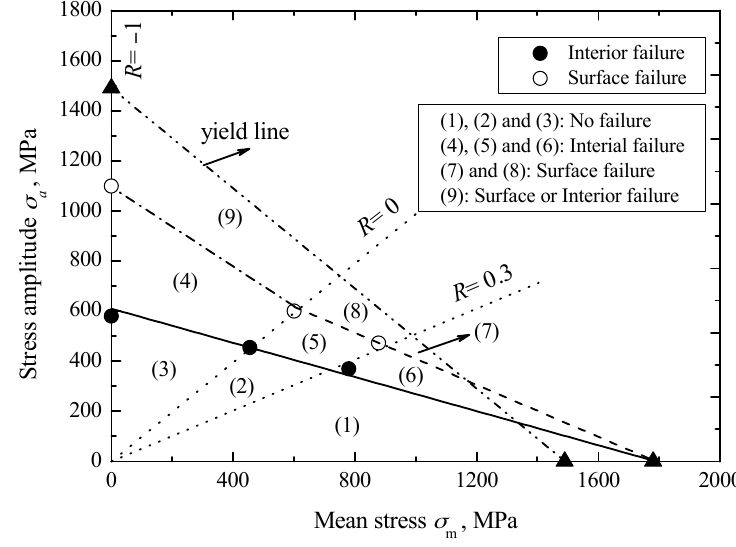
Figure 5. Constant life diagram of carburized Cr-Ni steel with two failure modes.